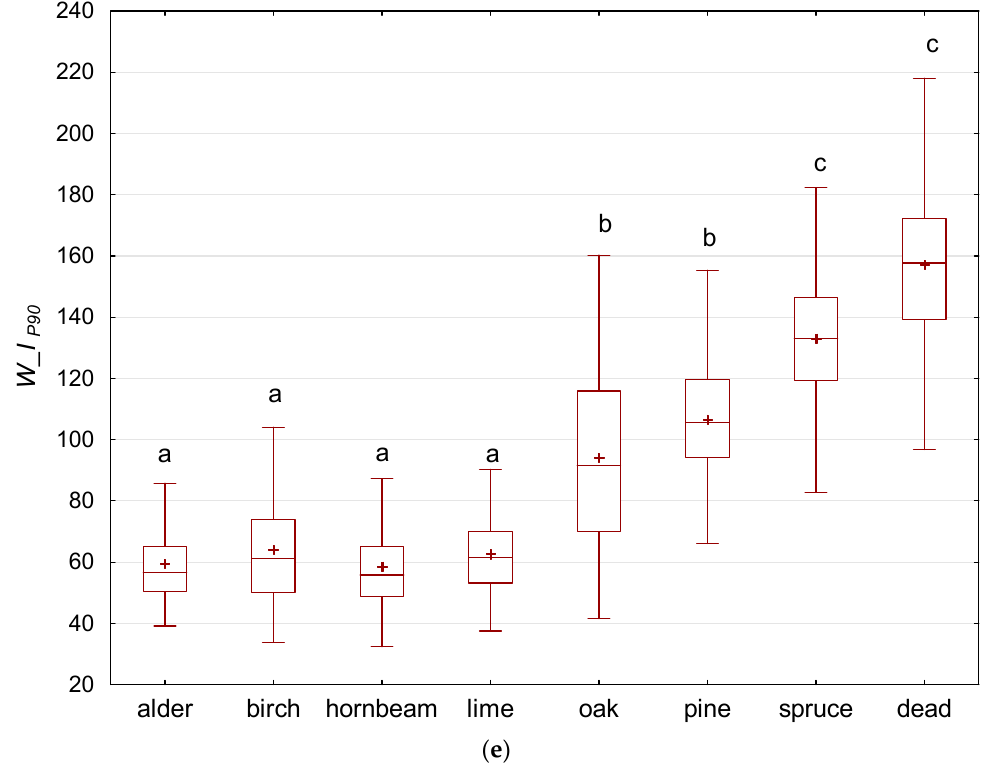
Figure 6. Box-and-whisker plot of the best predictors: ( a ) NDVI , ( b ) S_I CV , ( c ) S_I P90 , ( d ) W_I CV , and ( e ) W_I P90 for the sample trees analysed in the study. The first and third quartiles define the box, the median is shown as “—”, the mean is shown as “+”, and the whisker defines the range of the data without outliers. Letters a, b, … above the boxes identify groups with no significant differences (based on the Kruskal–Wallis test). The ALS is the point cloud from the leaf-on (S) or/and leaf-off (W) season, whereas the CIR is the spectral information derived from the colour-infrared images. The descriptions of the predictors are included in Tables 3 and 4.